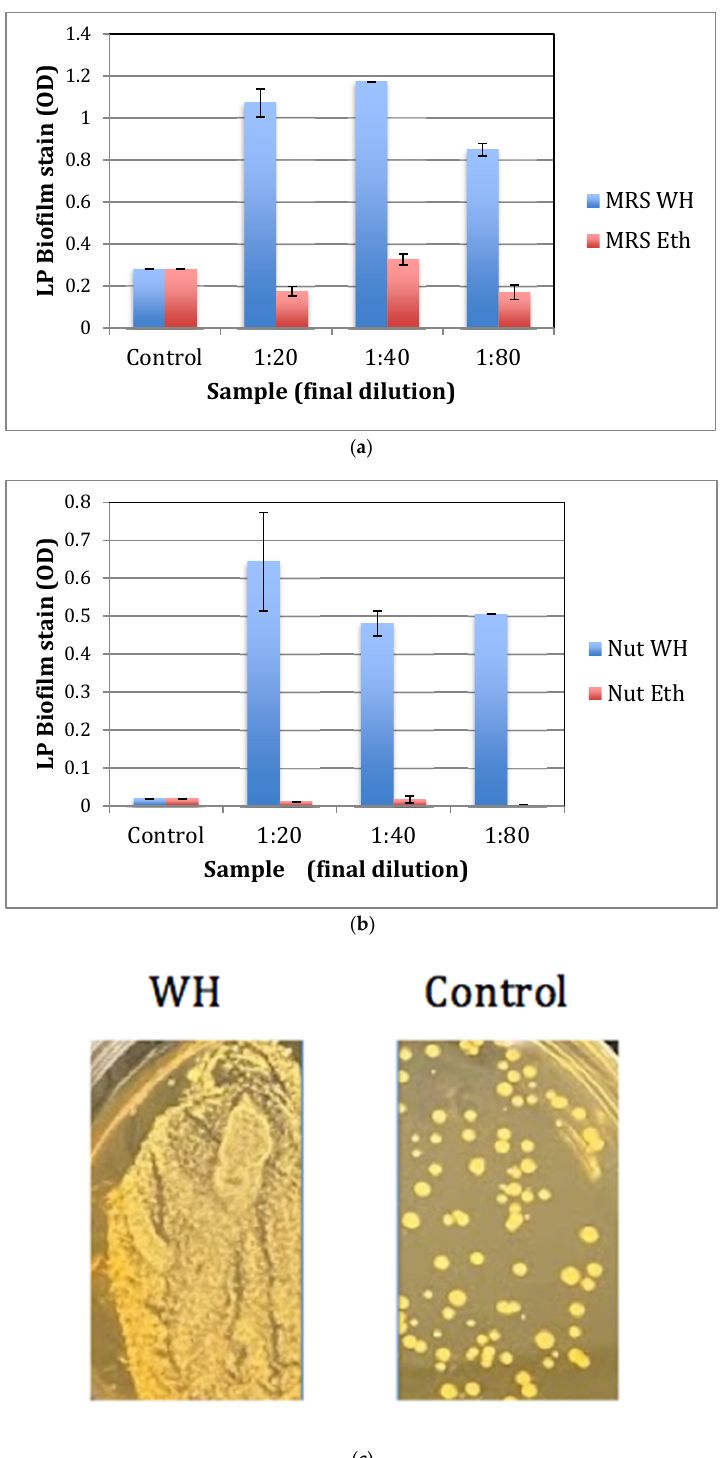
Figure 4. The effect of witch hazel on biofilm formation by L . plantarum. Bacteria were grown overnight in MRS ( a ) or nutrient broth (Nut) ( b ) in the presence of increasing amounts of whISOBAX (WH), ethanol (Eth), or medium alone (control). After 48 h, unbound bacteria were removed, bound (biofilm) bacteria were stained in crystal violet, stain was dissolved in SDS, and OD was determined. ( c ) Bacteria were grown with a final 1:20 dilution of WH or Eth control (see ( b ) above). Bound cells were resuspended in nutrient broth, and undiluted samples were streaked on MRS agar plates, which were placed in anaerobic chambers for 24